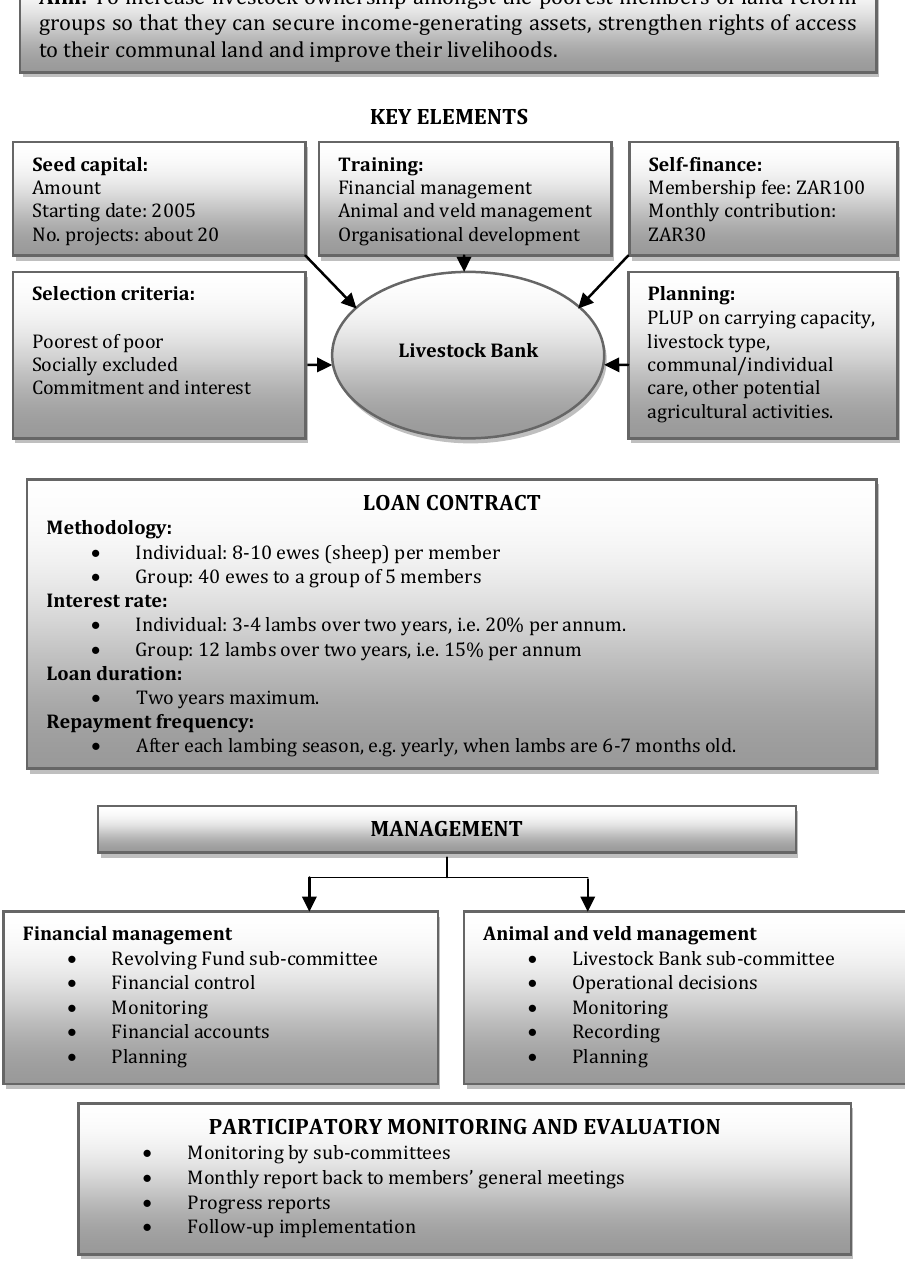
FIGURE 1: Livestock Bank Model (Original